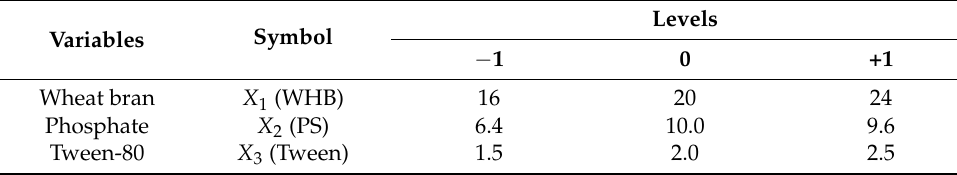
Table 6. Factors and their levels examined in the BBD.